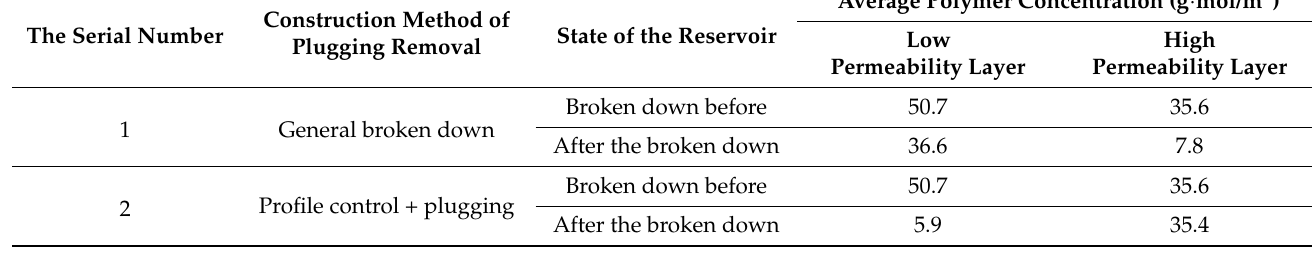
Table 7. Average polymer concentration in the vicinity of the wellbore.